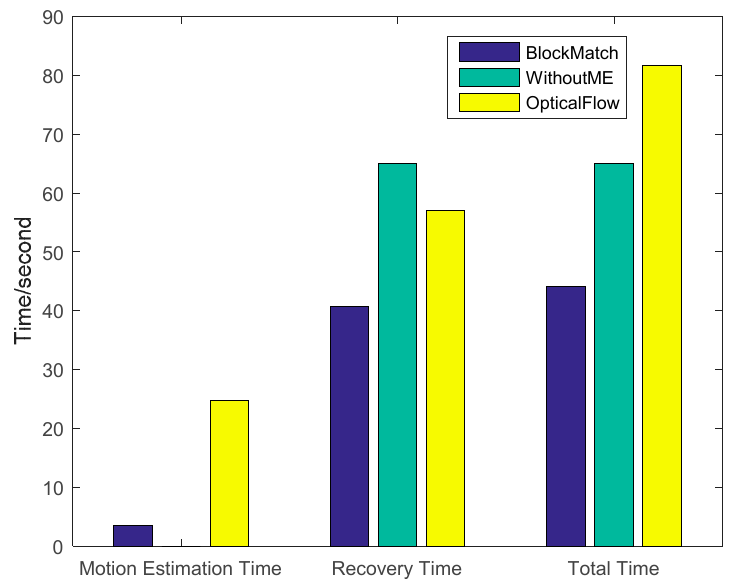
Figure 12. Time cost of the the images reovered by our block matching Scheme, the optical flow and